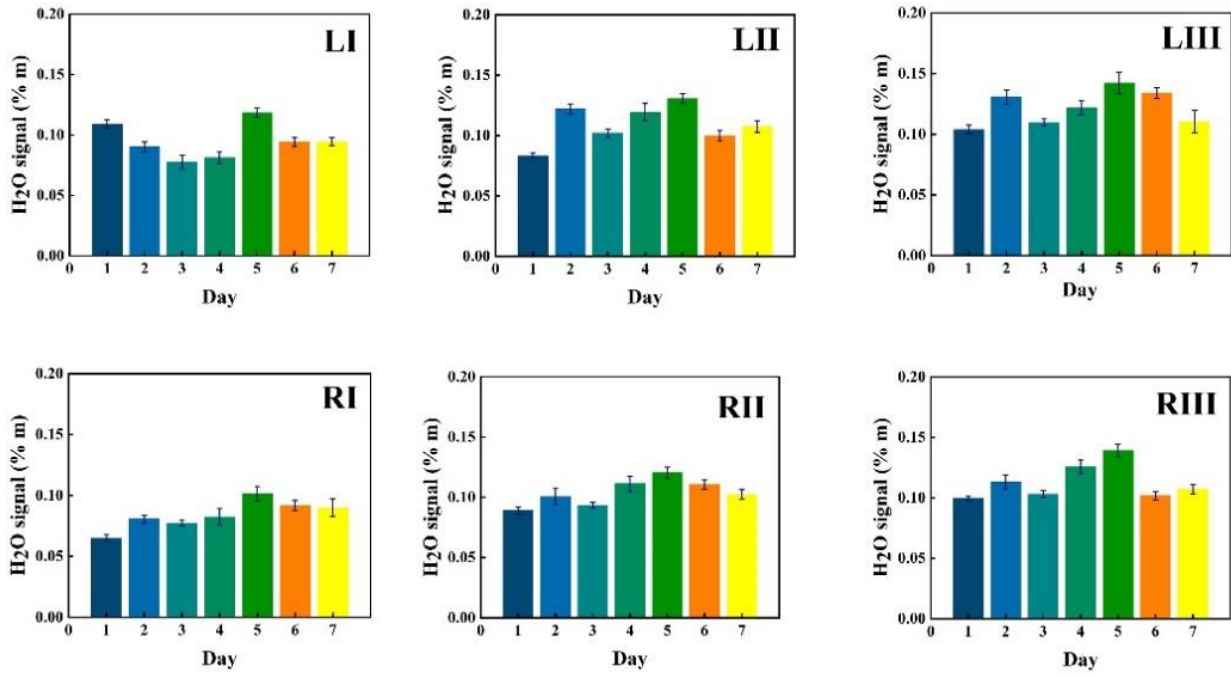
week, together with the standard deviation.